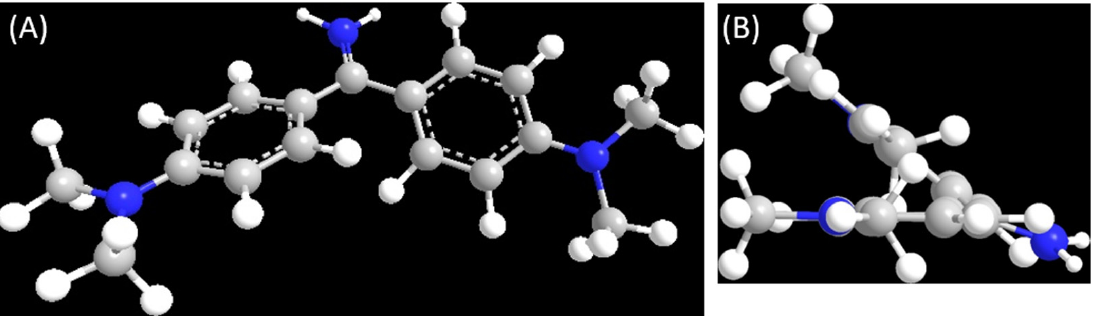
Figure 6. ( A ) Nonplanar structure of AO optimized using Chem3D (the force field MM2), and ( B ) the torsion angle of 40° between the two aromatic systems.